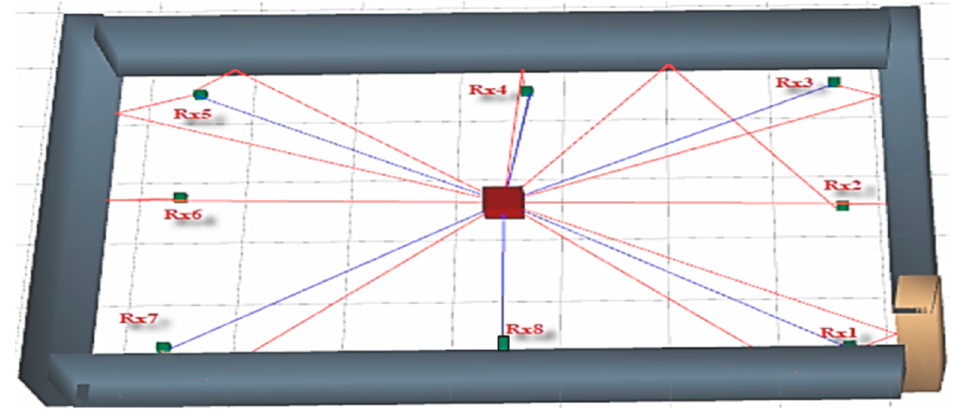
Figure 3. Ray tracing simulation using the SBRT method.